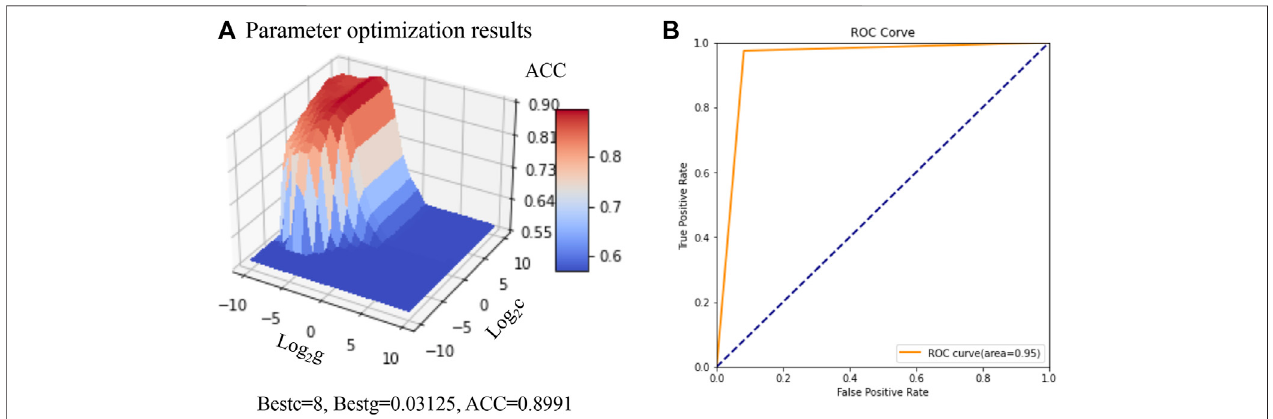
FIGURE4| ConstructionandoptimizationofSVMbasedprediction model. (A) ParameteroptimizationresultsbasedonGridsearchandcrossvalidation. (B) AUC of SVM based prediction model under the best parameters. AUC: area under receiver operating characteristic